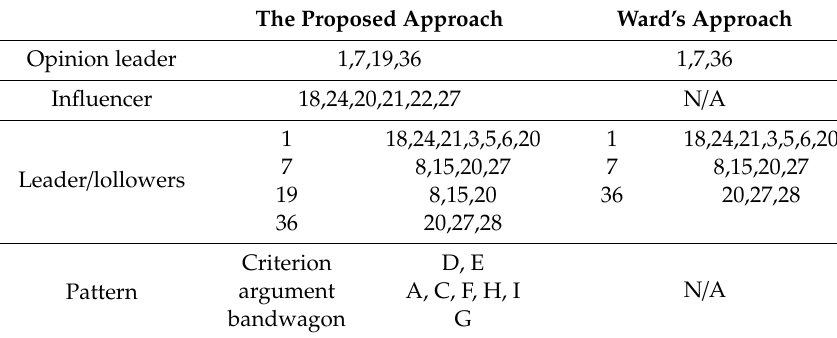
Table 3. Analysis